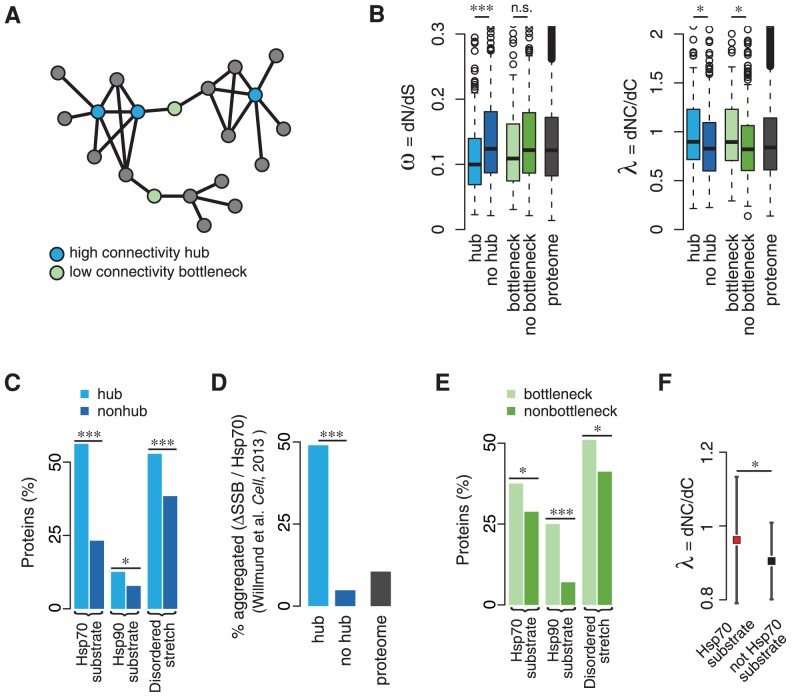
Selective protein quality control in the evolution of protein networks.
A Hubs comprise the most connected proteins in protein networks, while low connectivity bottlenecks are functionally important network nodes that connect network modules. B Hubs and bottlenecks as the most critical proteins in protein interaction networks are characterized by low ω, thus strong purifying selective pressure. Despite their generally high degree of conservation, both hubs and bottlenecks exhibit significantly higher distributions of λ. C Hubs compared to non-hubs are significantly enriched in chaperone substrates and proteins with long disordered stretches. D Deletion of the Hsp70s SSB1/2 (data obtained from [65]) results in 50% of the hubs, but less than 10% of the non-hubs to immediately aggregate. While SSB might not directly promote the evolution of hubs, it is instrumental in the homeostasis of intrinsically disordered hub proteins, thus serving as evolutionary potentiator. E Bottlenecks are significantly enriched in chaperone substrates and proteins with long disordered stretches compared to non-bottlenecks. F The Hsp70 SSB directly promotes non-conservative mutations in bottlenecks in addition to, but independent of intrinsic disorder. Significance levels are indicated as n.s. (not significant), * (p<0.05), and *** (p<0.001).